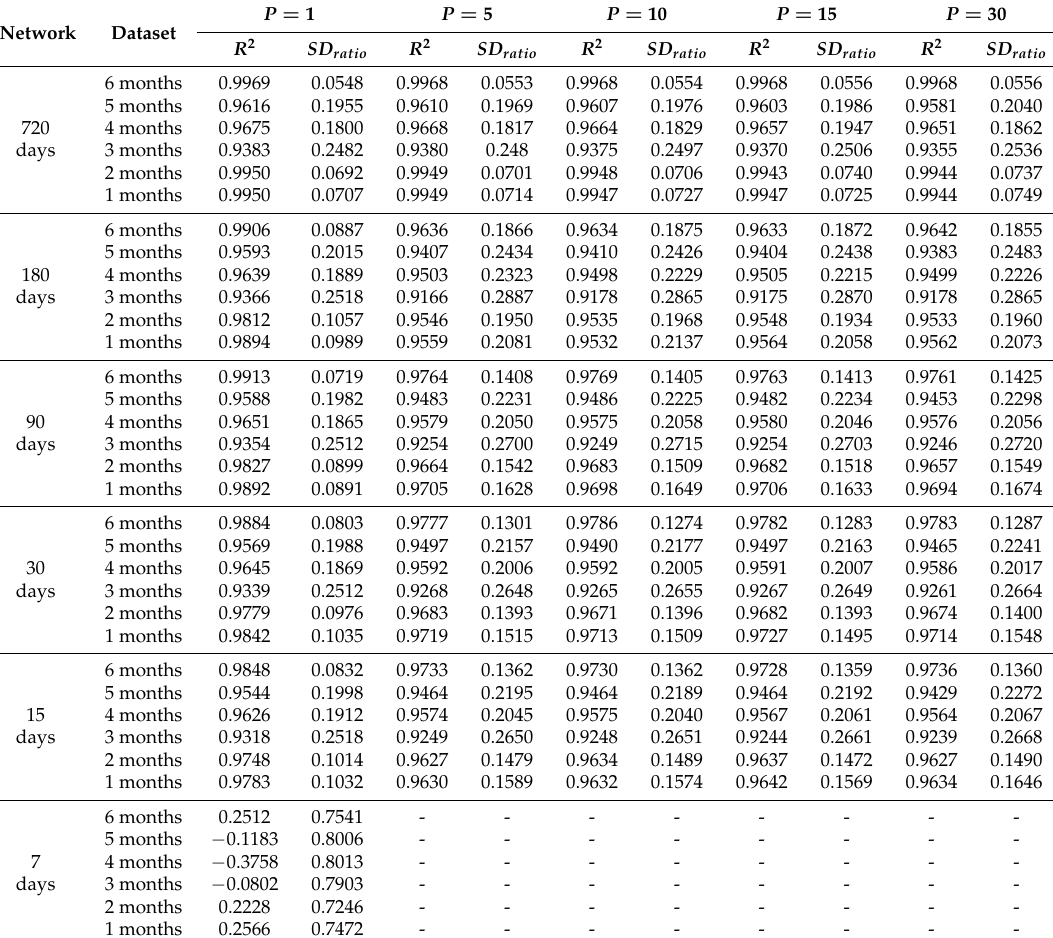
Table 10. Performance Indices for time horizon